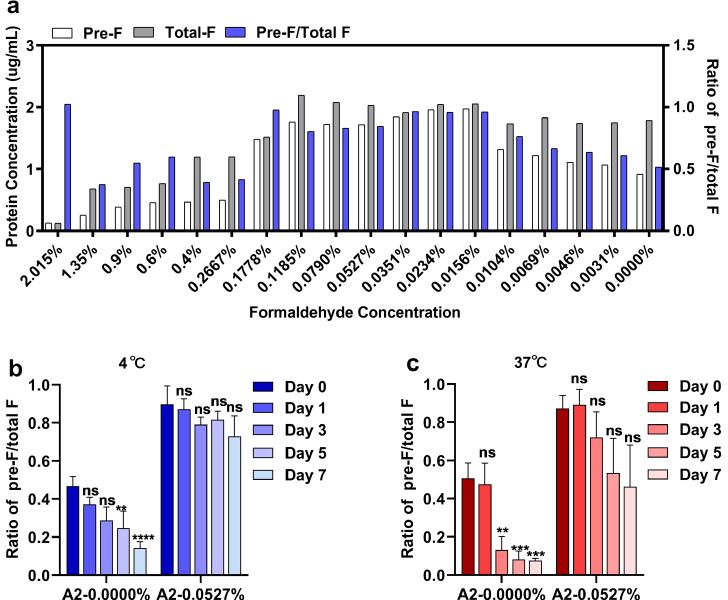
Figure 2. Optimal concentration of formalin to stabilize pre-F in RSV and thermal stability assay results. ( a ) Fresh RSV A2 virions were harvested and treated with the indicated concentrations of formalin at 25 °C for 24 h. Sandwich ELISA was performed to evaluate the concentration of F protein and the relative pre-F level. ( b , c ) The pre-F thermal stability was tested by incubation of fixed virus at 4 °C or 37 °C, and the ratio of pre-F to total F was determined by sandwich ELISA at the indicated time points.( a ) Each bar represents a single measurement. ( b , c ) The bars represent the mean ± SD from three experimental replicates combined, and the data were analyzed by two-way ANOVA followed by Dunn’s multiple comparisons post hoc test to compare the ratio on day 0 with the ratio on each other day. The adjusted p values are shown by asterisks (ns, not significant; ** p < 0.01; *** p < 0.0001; **** p <